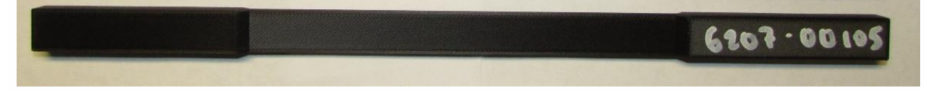
Figure 4. 3D printed test specimen from additive manufacturing before